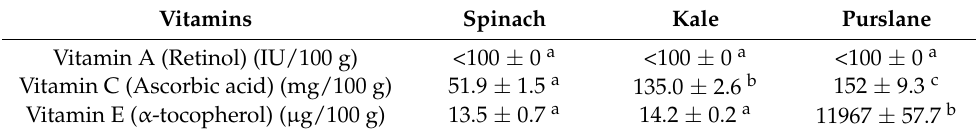
Table 4. Vitamin content in spinach, kale, and purslane [10] (Mean ± SD; n = 3), dry weight. Vitamins Spinach Kale Purslane Vitamin A (Retinol) (IU/100 g) <100 ± 0 a <100 ± 0 a <100 ± 0 a Vitamin C (Ascorbic acid) (mg/100 g) 51.9 ± 1.5 a 135.0 ± 2.6 b 152 ± 9.3 c Vitamin E ( α -tocopherol) ( µ g/100 g) 13.5 ± 0.7 a 14.2 ± 0.2 a 11967 ± 57.7